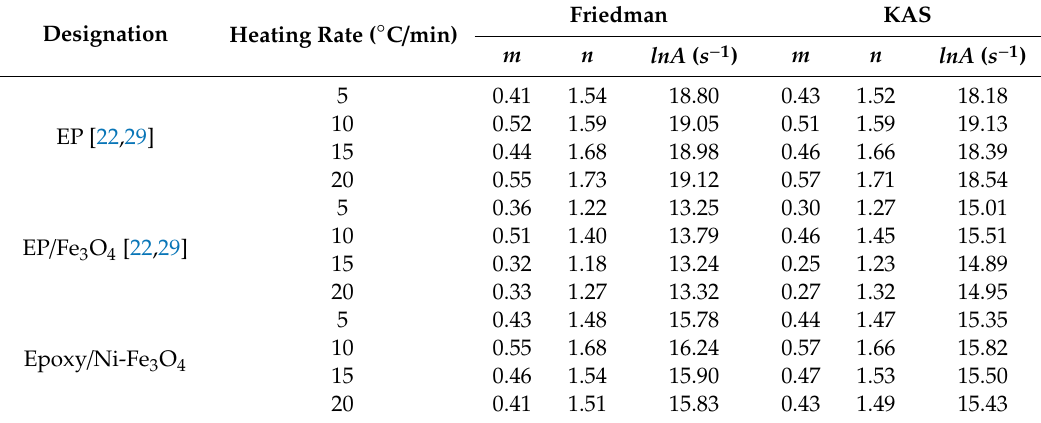
Table 3. Parameters of cure kinetics obtained from the Friedman and KAS models as a function of heating